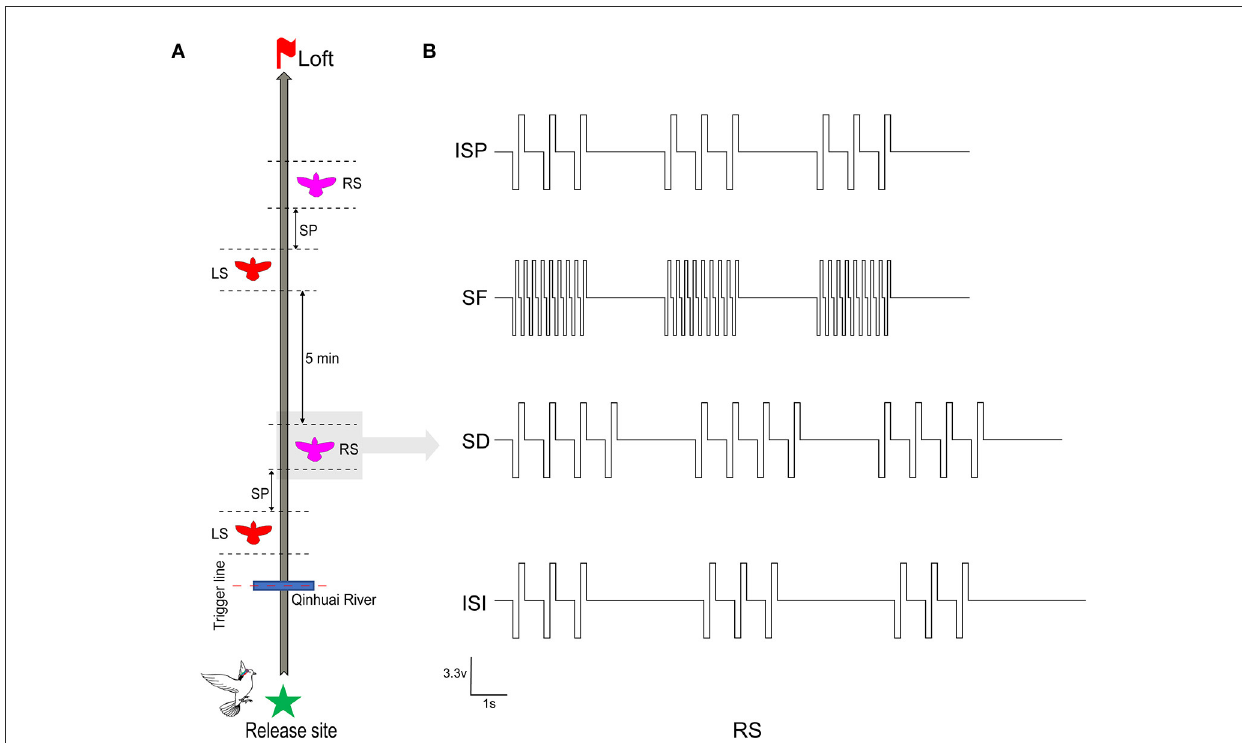
FIGURE2 Stimulation procedure and parameters in robo-pigeon. (A) The complete stimulus experiment procedures of each robo-pigeon. LS denotes that the robo-pigeon was stimulated in the left-FRM, and RS in the right-FRM. SP denotes the unstimulated silent period between the left stimulus and right stimulus segments. (B) The various electrical stimulation parameters used in the present study. ISP, initial stimulation paradigm; SF, stimulus frequency; SD, stimulus duration; ISI, inter-stimulus interval.